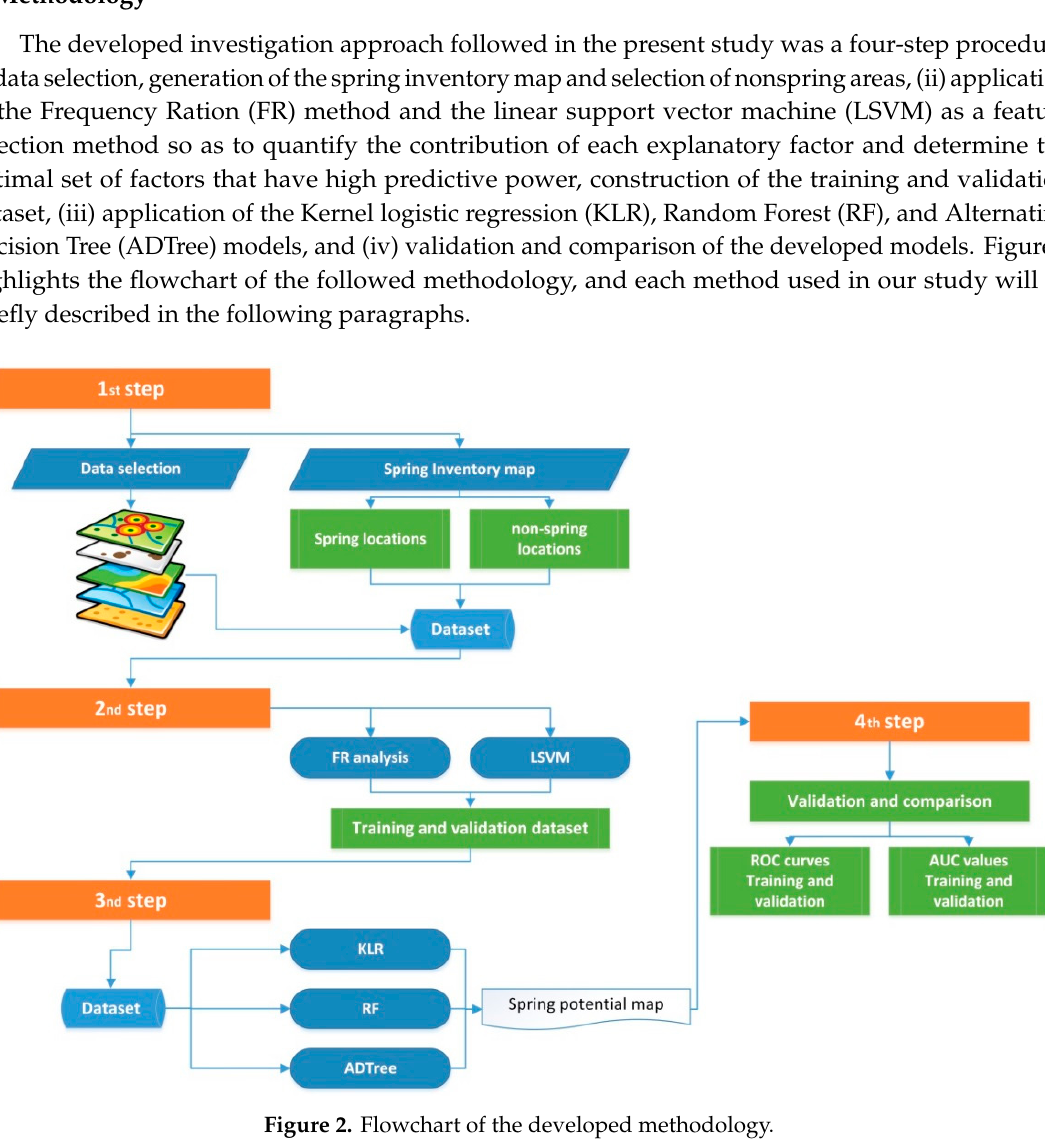
Figure 2. Flowchart of the developed methodology.